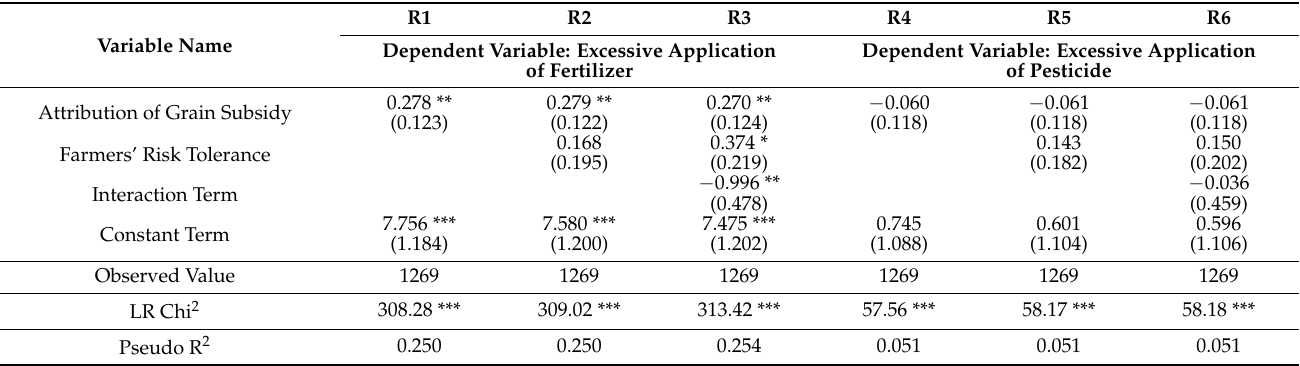
Table 9. The moderating effect of farmers’ risk tolerance on the impact of grain subsidy policy on farmers’ green production